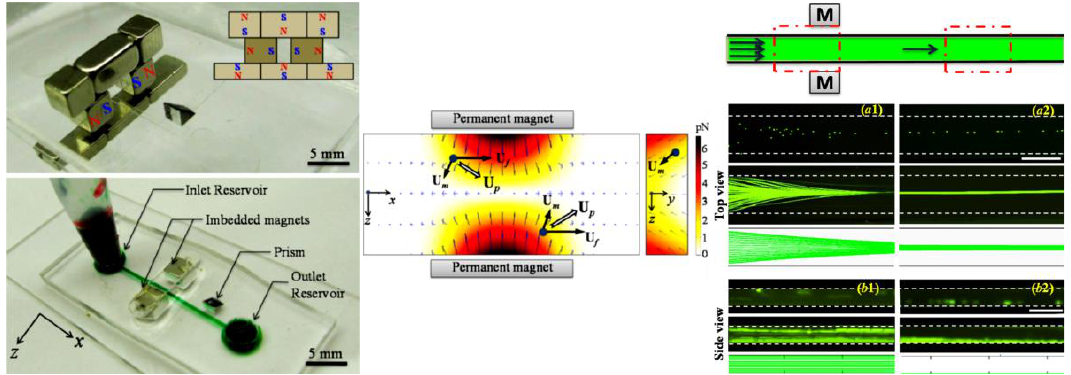
Figure 5. Diamagnetic particle focusing in ferrofluid flows under the magnetic field of a pair of repulsing magnets: Picture of the placed magnets/prism (upper left) for fabricating the microfluidic device (lower left); Velocity analysis of diamagnetic particles in the flow of ferrofluid in the horizontal and vertical planes of the microchannel (middle); Experimental and theoretical images of the 2D focusing (i.e., both horizontal and vertical) of 5 μm diamagnetic beads before and after the magnet pair (right). Adapted with permission from Zeng et al. [93], © 2012 IOP Publishing